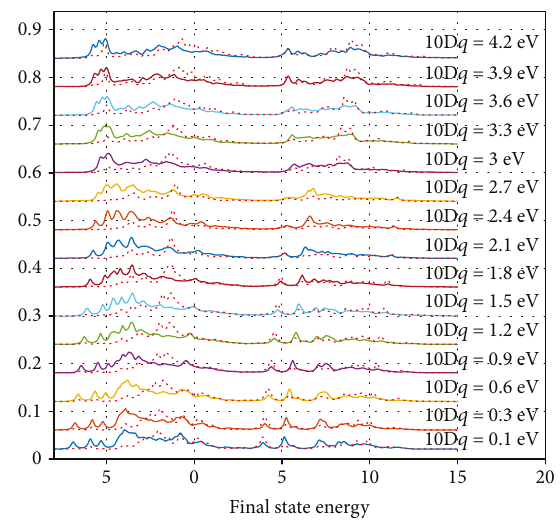
Figure 38: 1s XAS projections for Fe 3+ ( 3d 5 ) with the corresponding ELD. Notice the high spin to low spin transitions in the ground and intermediate states between 10D q ≈ 3 0 eV and 3.3